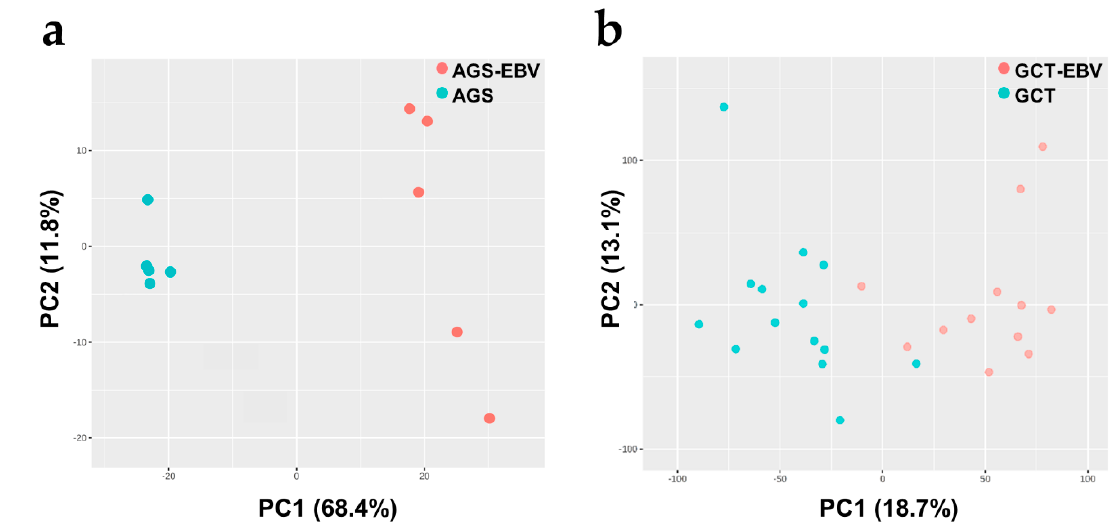
Figure 1. Principal component analysis (PCA) score plots of differences in transcriptome profiles ( a ) between AGS-Epstein–Barr-virus (EBV) and AGS and ( b ) gastric cancer tissue (GCT)-EBV and GCT. Both comparisons reveal clear separations caused by the association of EBV with gastric cancer.